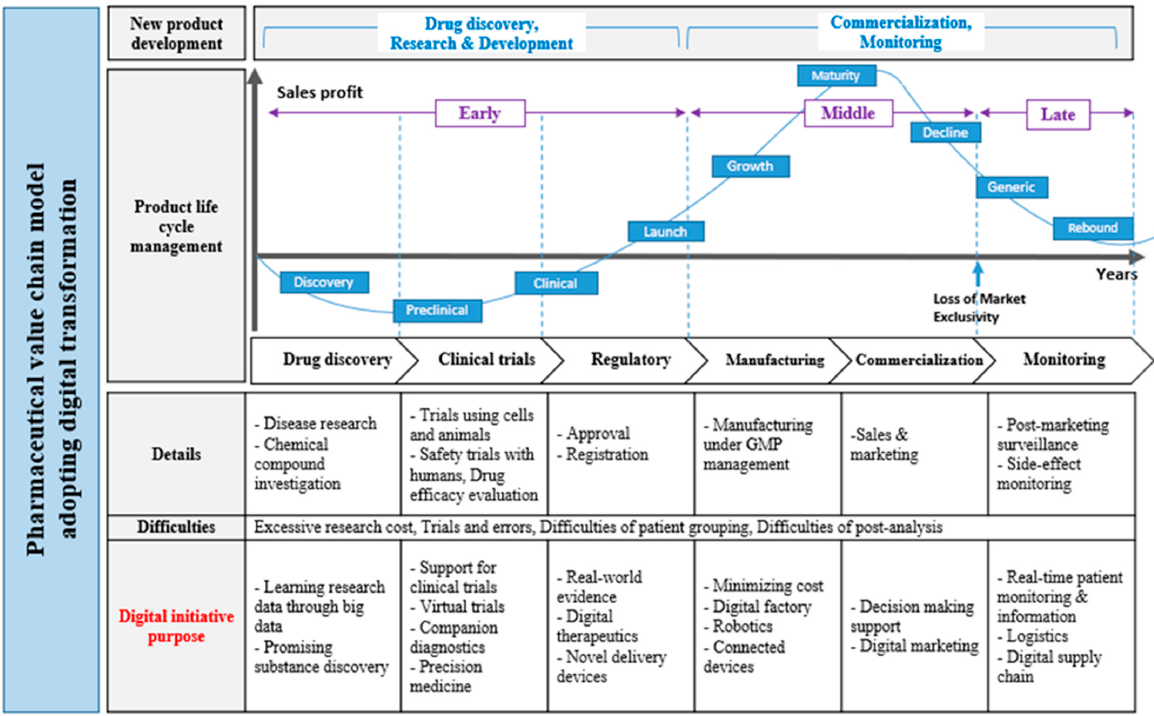
Figure 1. A New Digital Value Chain Framework for the Biopharmaceutical Industry. Source: Figure 1 is a modified and further developed model based on Korea Health Industry Development